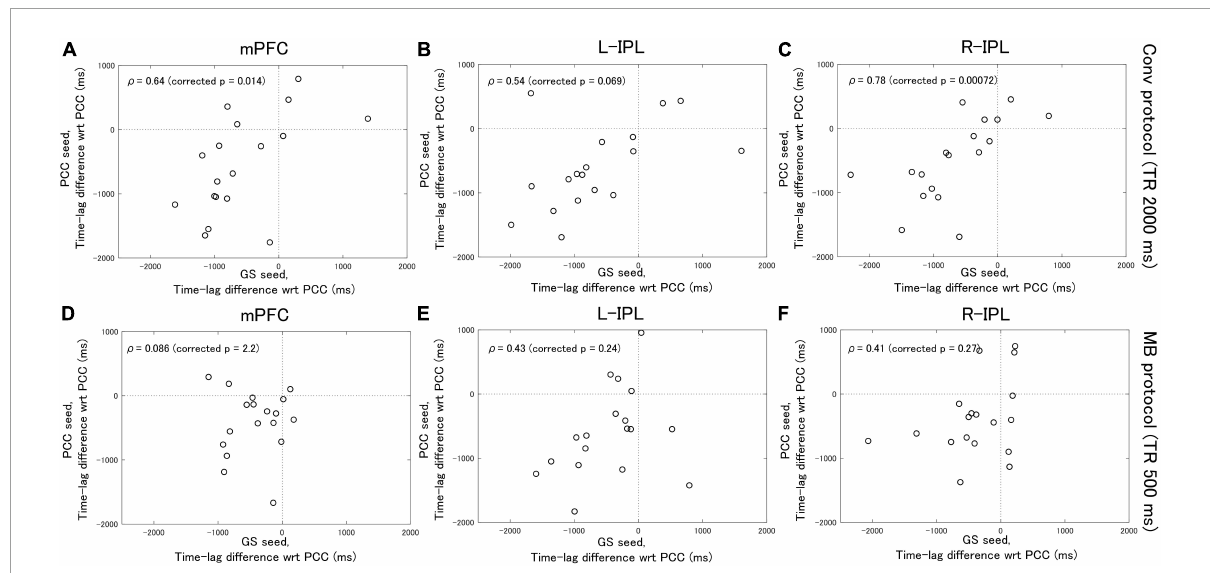
FIGURE4 Spearman’s correlation analysis between the time-lag differences calculated with the PCC seed and those calculated with the GS seed. Eighteen healthy female volunteers participated in this study. (A–C) Results calculated from the Conv protocol data. (D–F) Results calculated from the MB protocol data. The correlations obtained for the MB protocol data were considerably weaker than for the Conv protocol